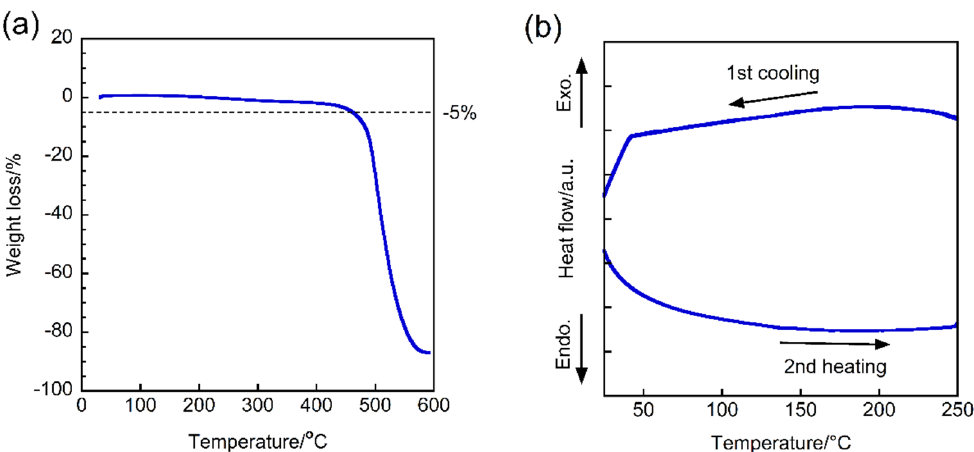
Figure 3. ( a ) Thermogravimetric analysis (TGA) and ( b ) di ff erential scanning calorimetry (DSC) charts of